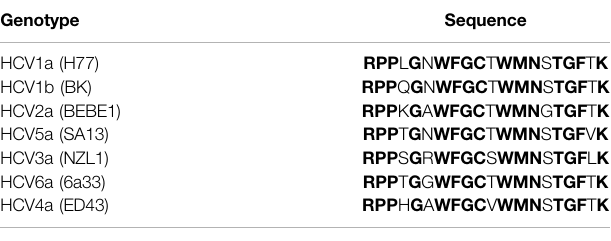
TABLE 10 | Alignment of segment 543 – 562 from various genotypes of HCV. In bold are represented the highly conserved residues. Genotype Sequence